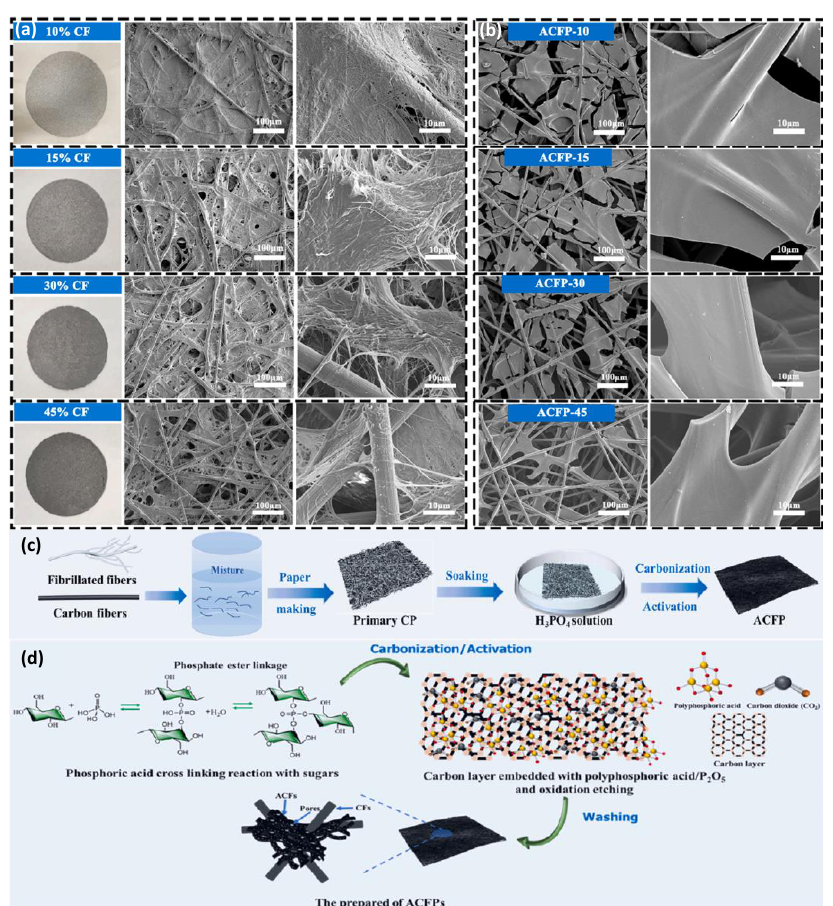
Figure 8. ( a ) Photographs and SEM images of primary CPs with different magnification (10% CF, 15% CF, 30% CF, 45% CF). ( b ) SEM images of cellulose-based ACFPs with different magnification (ACFP-10, ACFP-15%, ACFP-30, ACFP-45). ( c ) Schematic illustration of the fabrication of cellulose based ACFPs. ( d ) The process and mechanism of ACFP structure and pore formation. Reproduced with permission [154] Copyright © 2022, Chemical Engineering Journal.